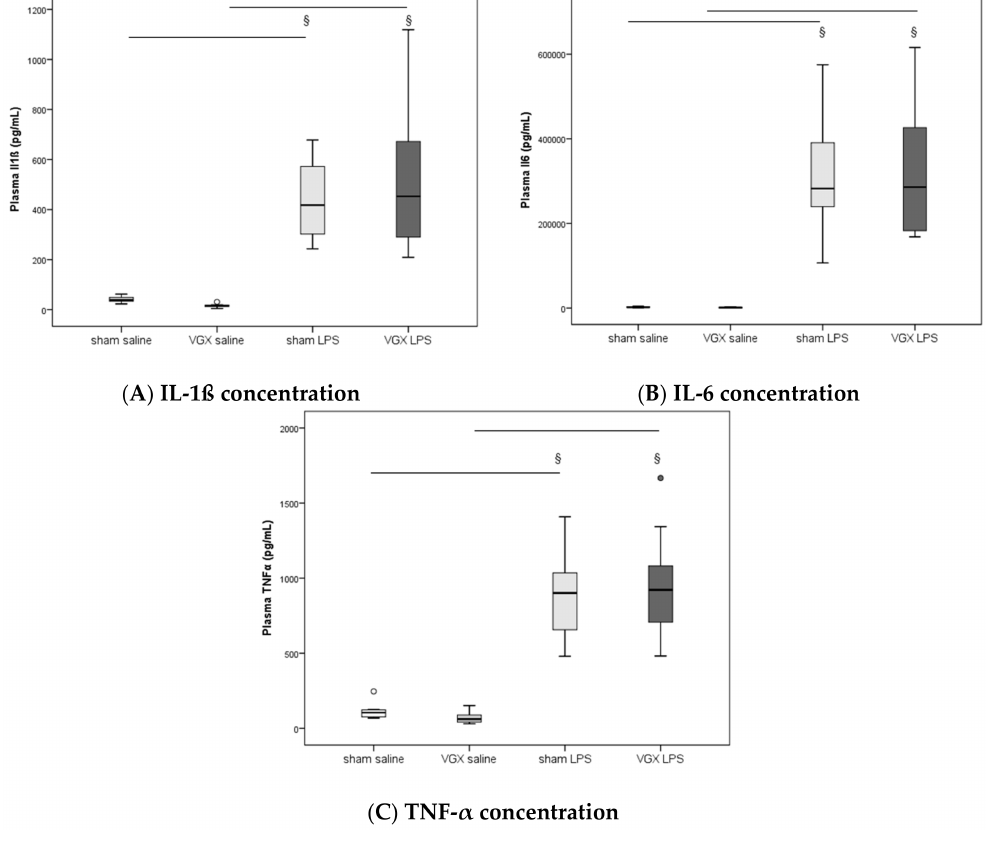
Figure 3. Plasma pro-inflammatory cytokines (( A ) IL-1ß, ( B ) IL-6, ( C ) TNF- α ) at the end of the experiment. Plasma data presented as median (IQR = Inter Quartile Range, in pg/mL) at 4 h after LPS injection (T5). No significant effect of nerve resection (VGX) was obtained ( p > 0.05). Significant LPS effect ( § : sham LPS versus sham saline and VGX LPS versus VGX saline, p ≤ 0.001 for both) was detected in all plasma proinflammatory cytokines measured. The circles present